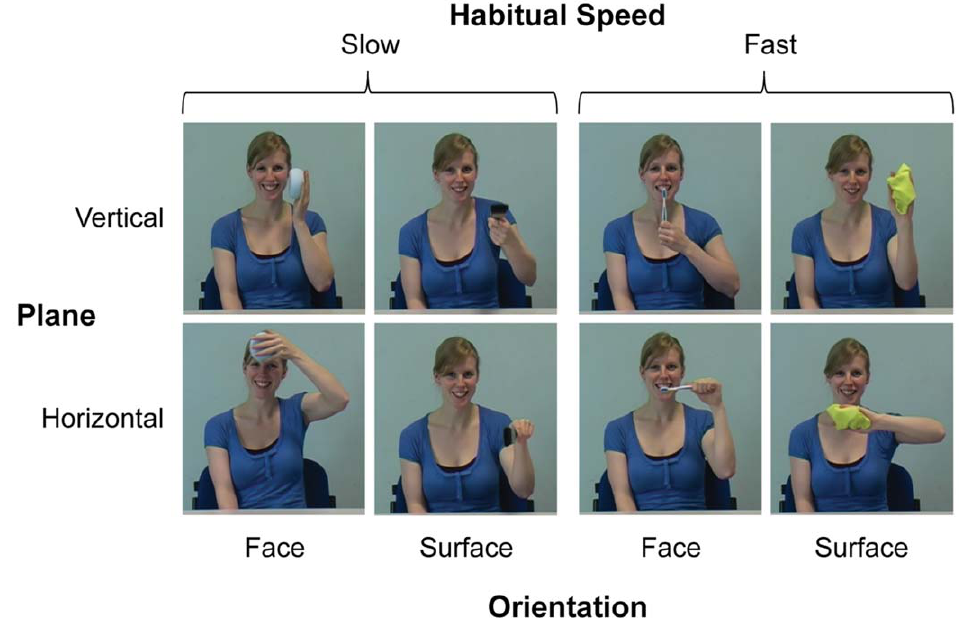
Figure 1. Imperative action stimuli with the factors plane, habitual speed, and orientation.